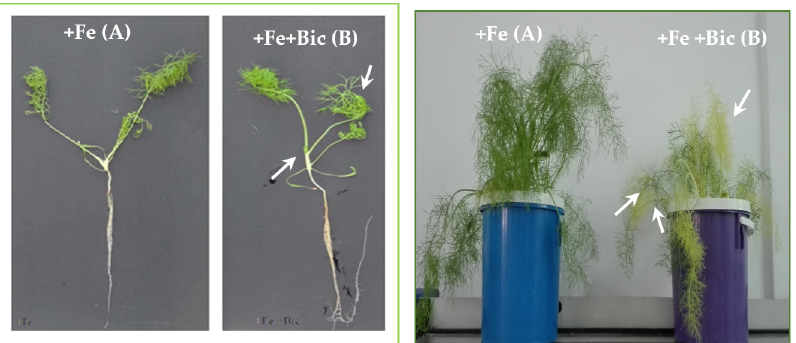
Figure 1. Morphogenic changes in fennel plants cultivated ( A ) under Fe sufficiency (+Fe) or ( B ) under Fe deficiency (+Fe +Bic), after a period of cultivation of 14 days. Arrows indicate intercostal chlorosis.